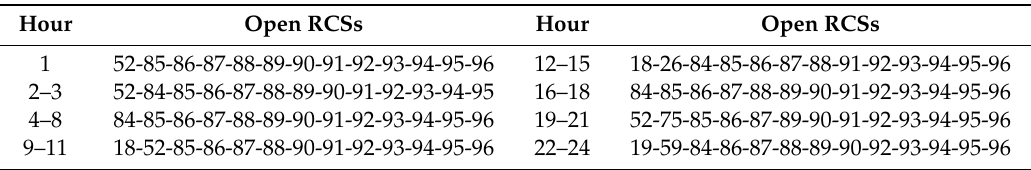
Table 5. Opened Remotely Controlled Switches (RCSs) in reconfiguration